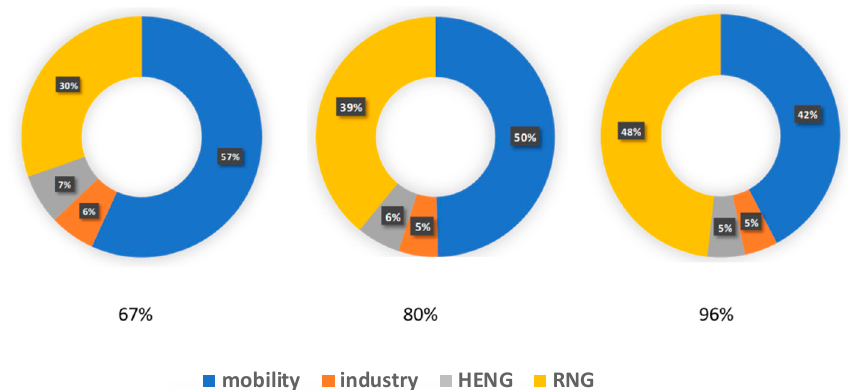
Figure 6. H 2 allocation at three different capacity factors.